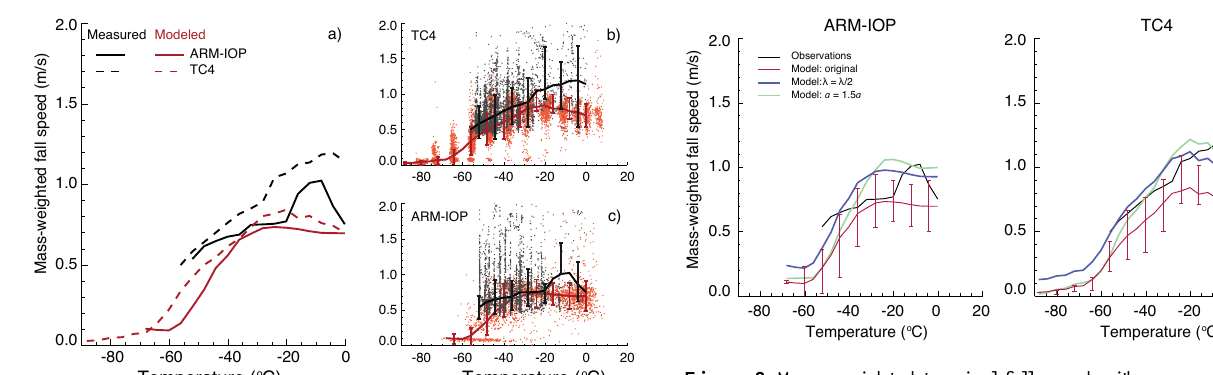
Figure 8. Mass-weighted terminal fall speed with snow and cloud ice λ = λ/ 2 (blue), and a i and a s increased with 50%